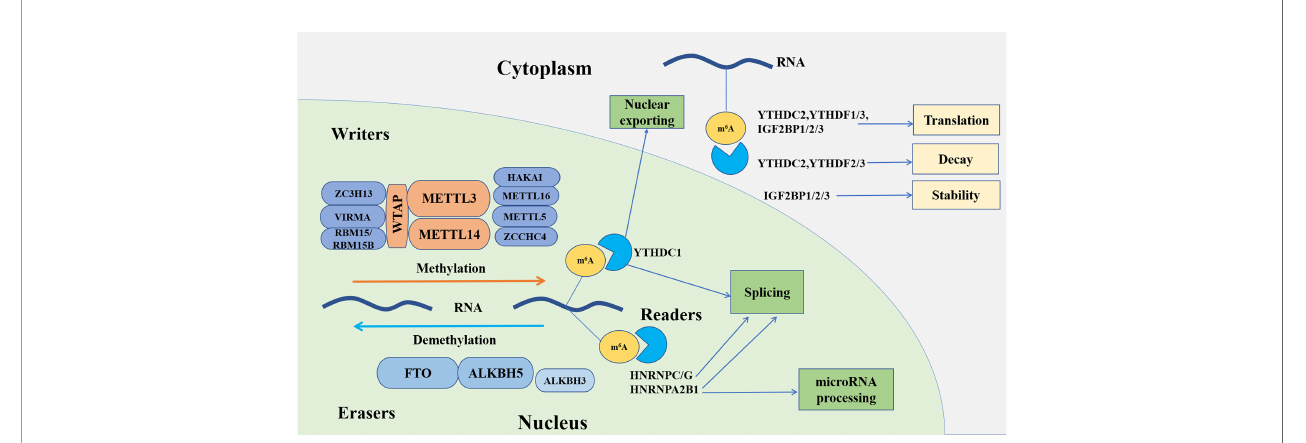
FIGURE 1 | The functions of m 6 A RNA modi fi cation. m 6 A writers and erasers reversibly and dynamically regulate the m 6 A methylation modi fi cation. Readers can recognize and bind to the m 6 A methylation site to in fl uence RNA fate, including nuclear exporting, splicing, stability, decay, and translation, as well as microRNA